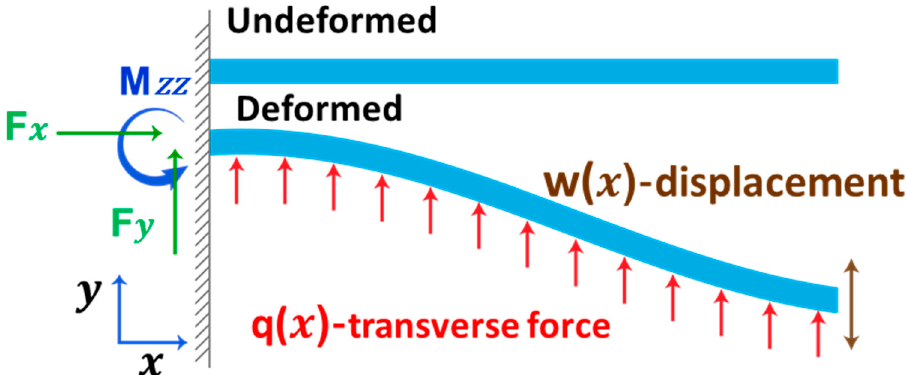
Figure 2. Schematic illustration of the distribution of surface stress on a cantilever under deformation.